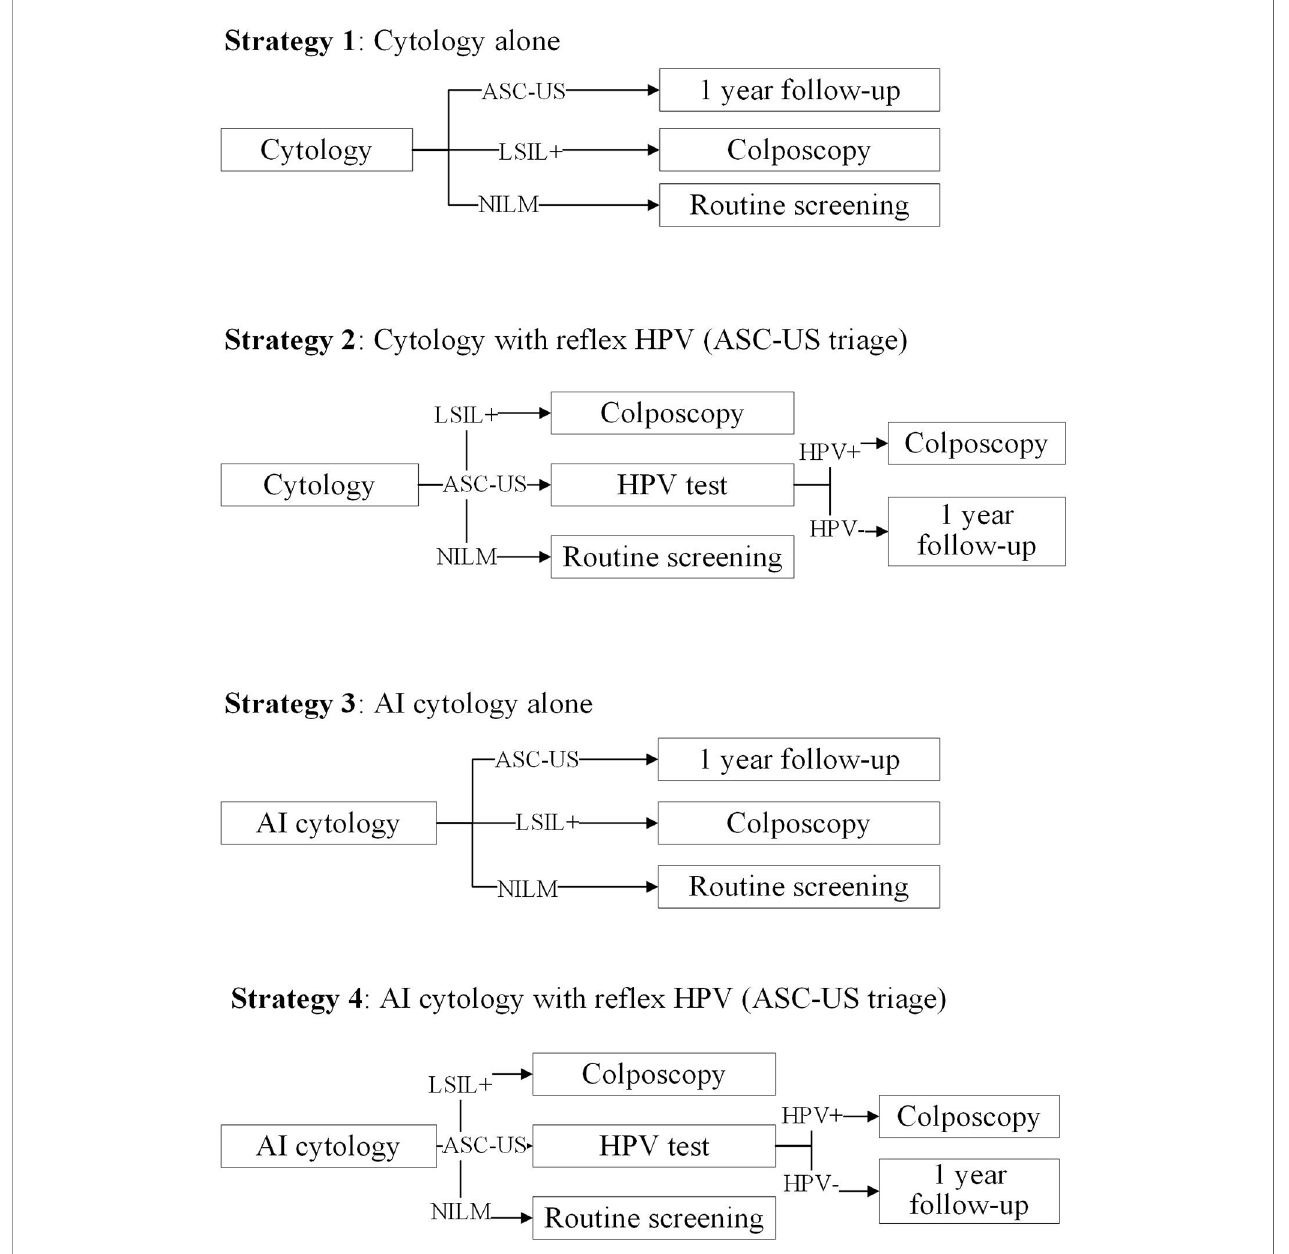
FIGURE 1 | Primary cytology screening strategies in the study. ASC-US, atypical squamous cells of undetermined signi fi cance; LSIL, low-grade squamous intraepithelial lesion; HPV, human papillomavirus; AI, arti fi cial